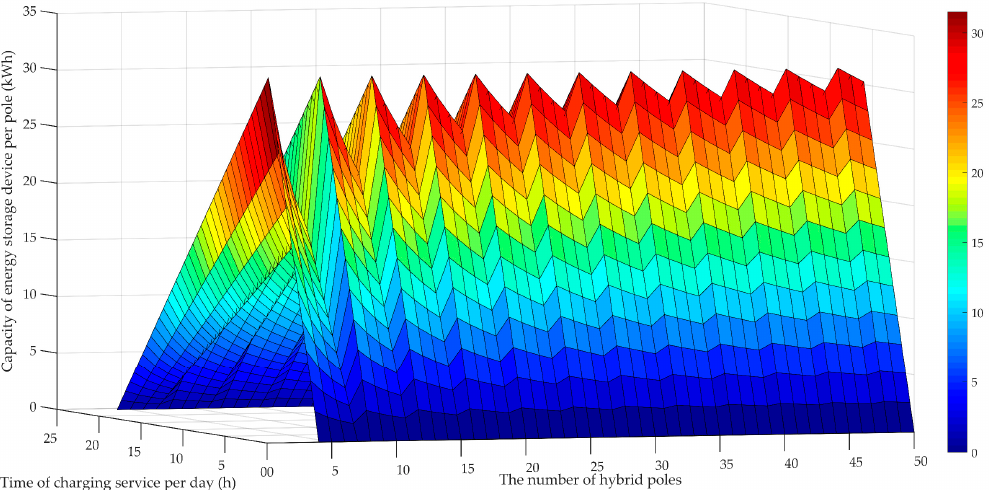
Figure 6. The functional image of capacity of the energy storage device per pole.